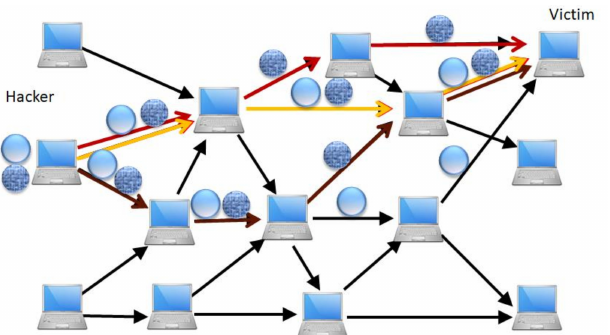
Figure 8. Improvements in the PSO algorithm when using the two-group strategy in the route- searching